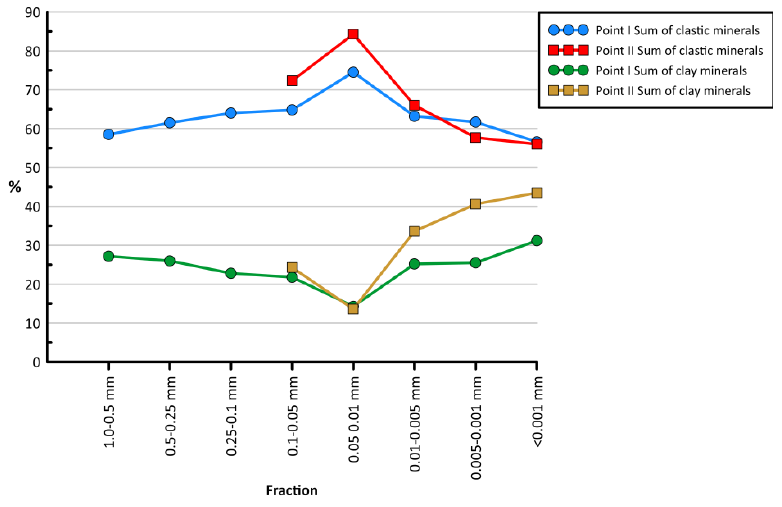
Figure 8. Variations in the sum of clastic and clay minerals at sampling points I and II.